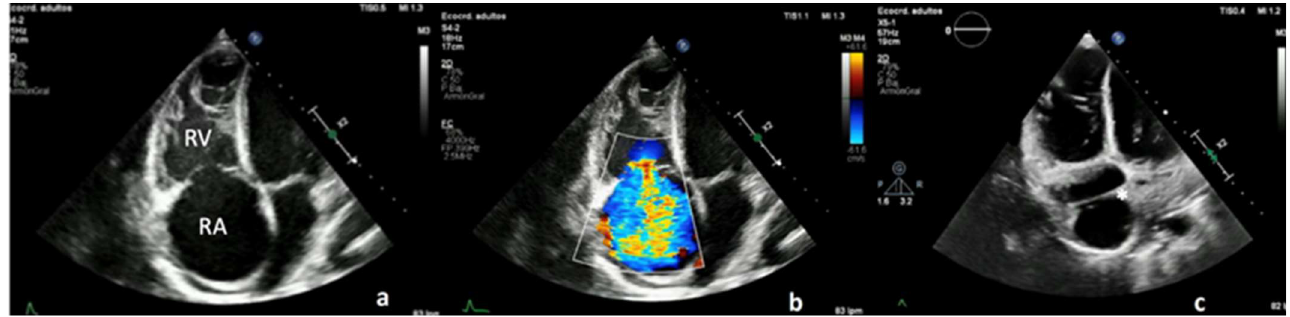
Figure 1. Transthoracic echocardiogram with severe right atrial (RA) and ventricular enlargement ( a ), severe tricuspid regurgitation ( b ) with an anomalous mobile membranous band-like structure crossing the RA (with asterisk in ( c )). RV: Right ventricle RA: right